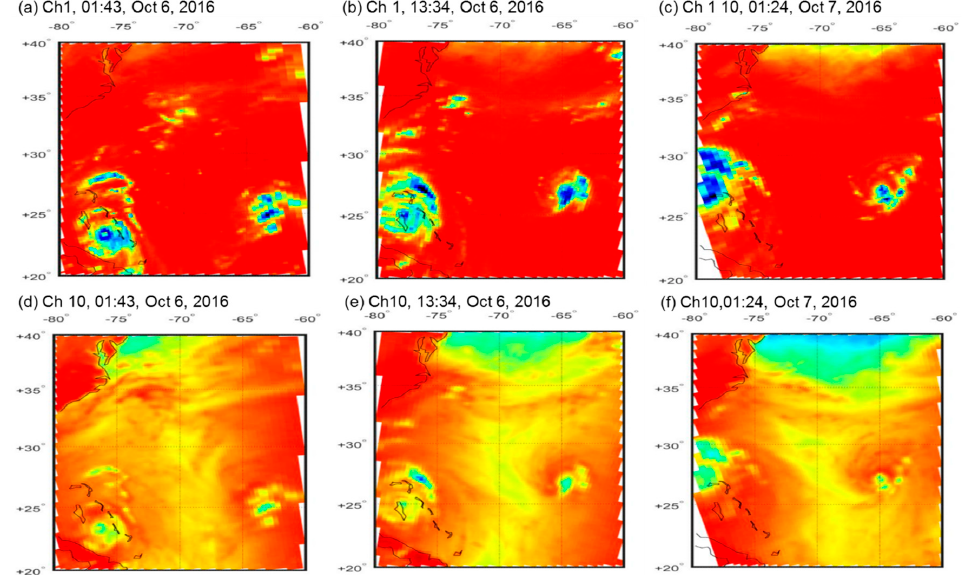
Figure 7. Sample observations from the first and tenth channel of MWHTS onboard the FY-3C satellite at different time during hurricane Matthew.